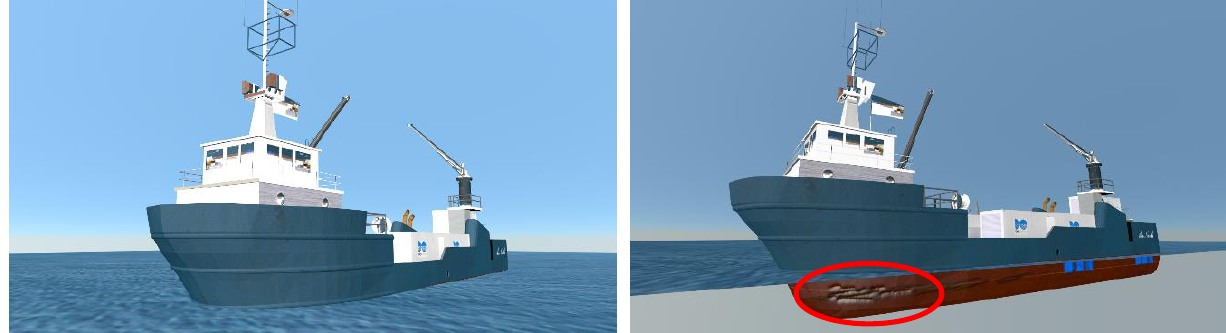
Figure 1. A ship whose hull (immersed part) has been damaged after a collision. The paper presents a low-cost but reliable and precise